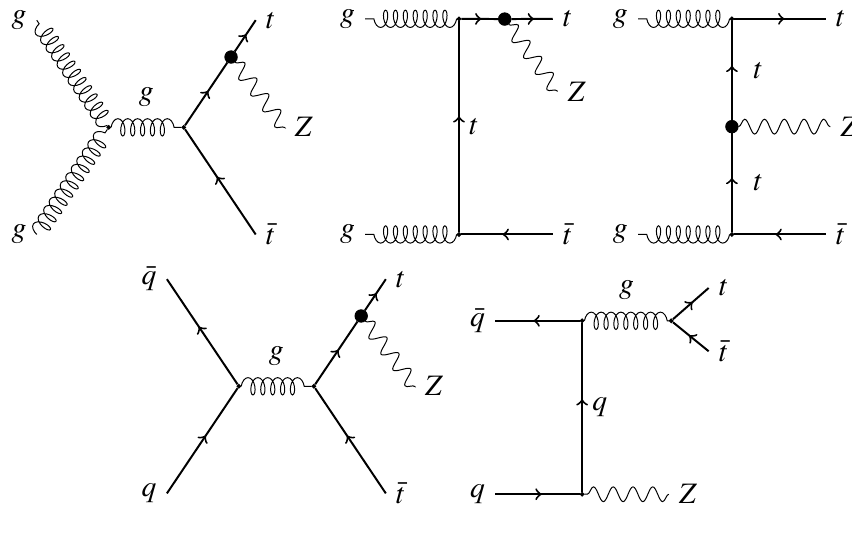
Figure 1 . Representative Feynman diagrams for t ¯ tZ production at leading order at the LHC. The 1 shaded blob presents the presence of anomalous t ¯ tZ